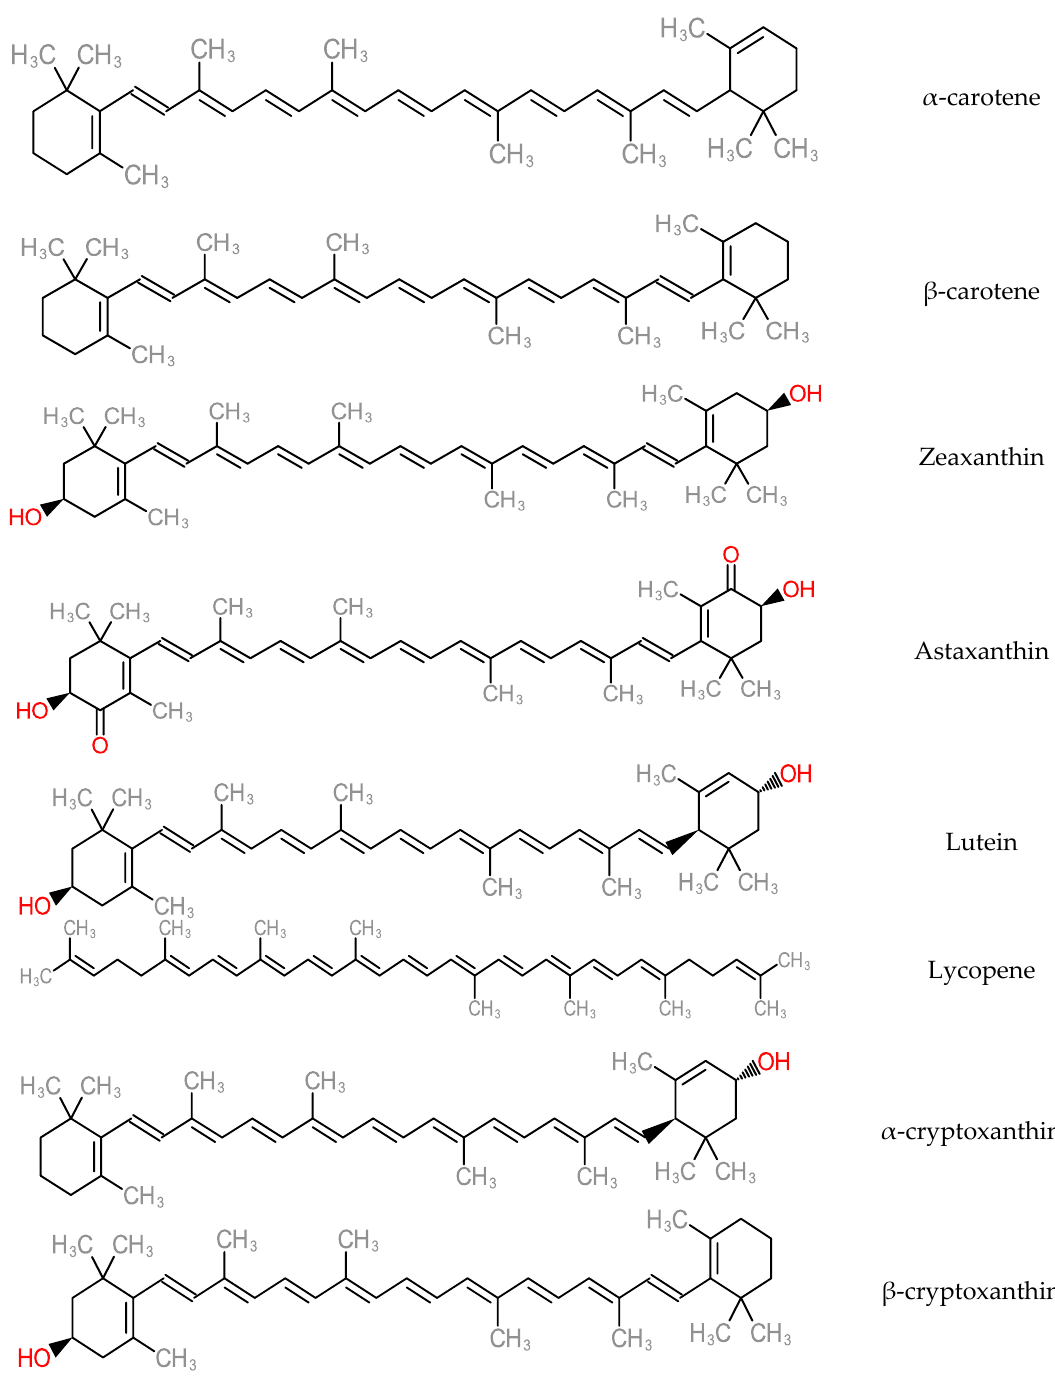
Figure 14. Structure of Carotenoids.